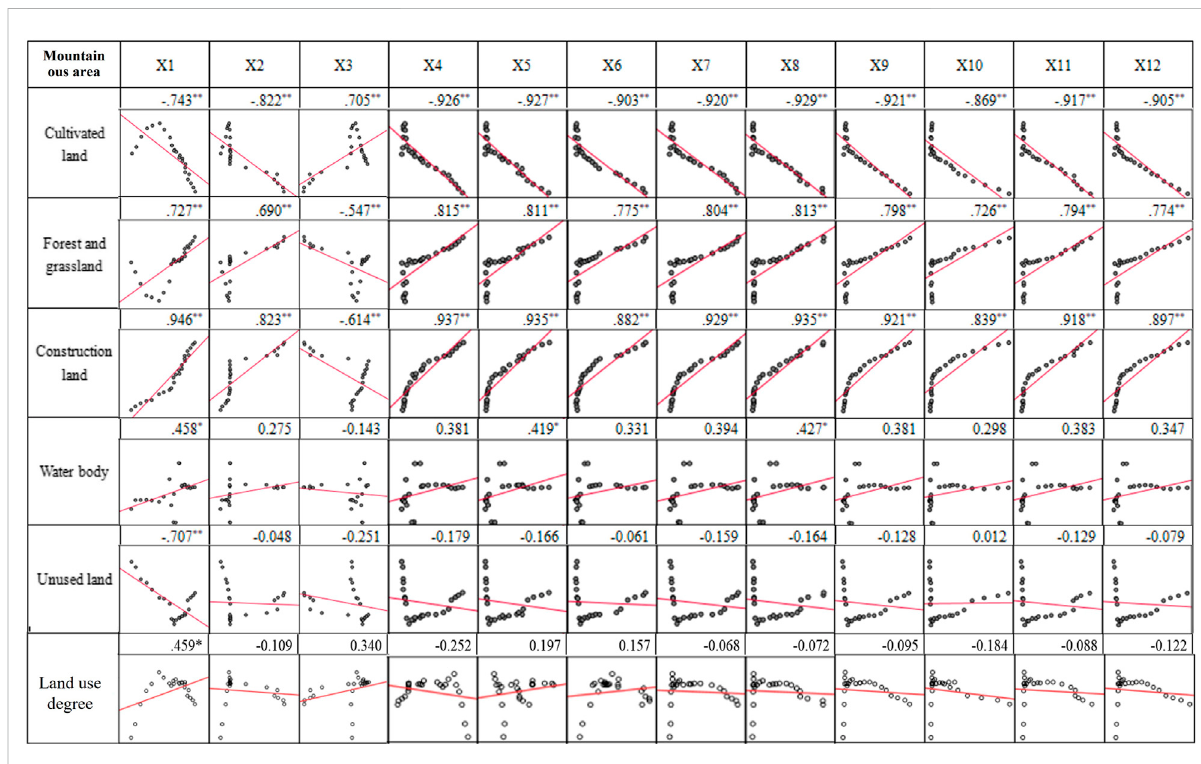
FIGURE 7 Correlation between land use types, land use degree and in fl uencing factors in the mountainous